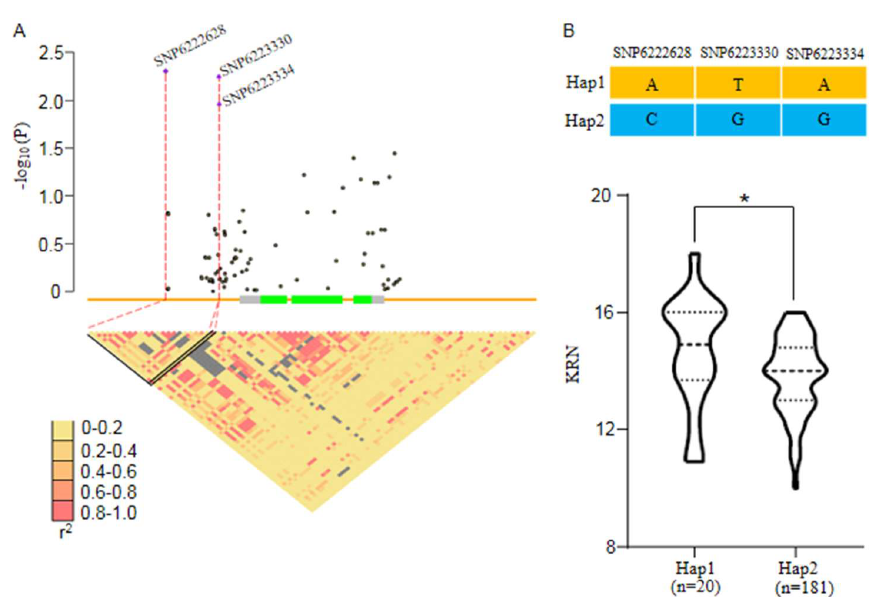
Figure 8. Natural variations in Zm00001d048841 were significantly associated with maize KRN. ( A ) Zm00001d048841 -based association mapping and pairwise LD analysis. The dots represent SNPs, and the triangles denote the lead SNP. The SNPs showing strong LD with the lead SNP are connected to the pairwise LD diagram with dotted lines and highlighted with red lines. ( B ) Haplotypes (Hap) of Zm00001d048841 among maize natural variations. “ n ” denotes the number of genotypes belonging to each haplotype group. The KRN of each haplotype group is displayed as a violin plot. Statistical significance was determined using a two-sided t -test. Asterisks indicate significant differences: * p < 0.05.